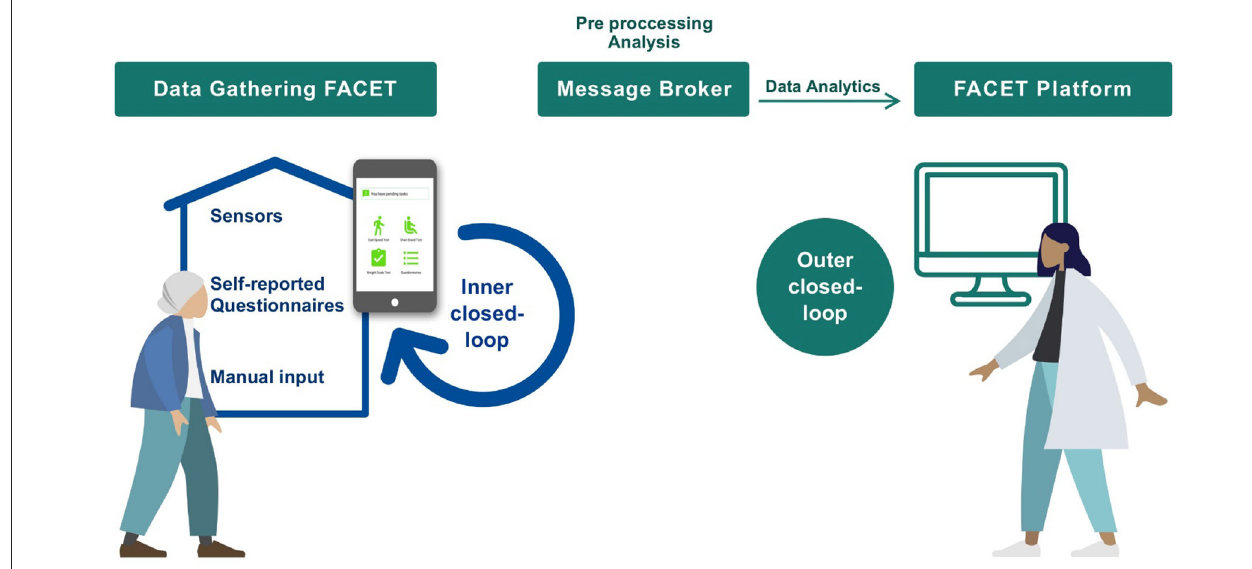
FIGURE 1 | Description of the FACET system that incorporates our